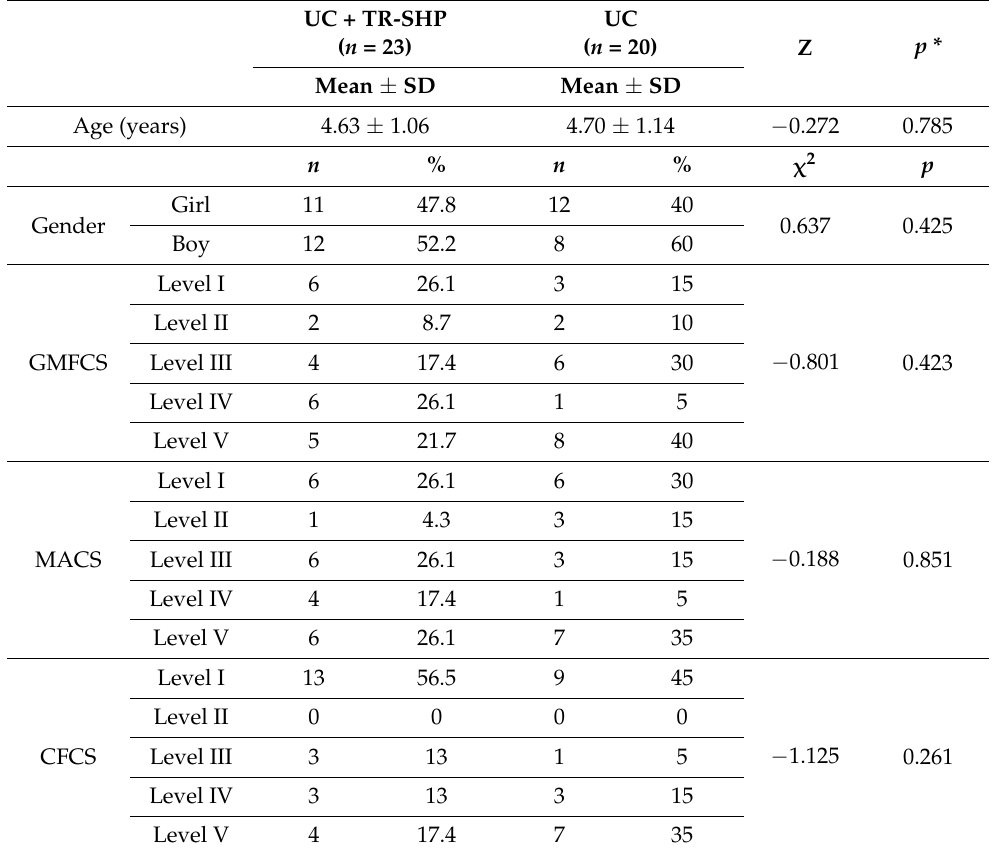
Table 2. Comparison of demographic and physical characteristics of the groups. UC +